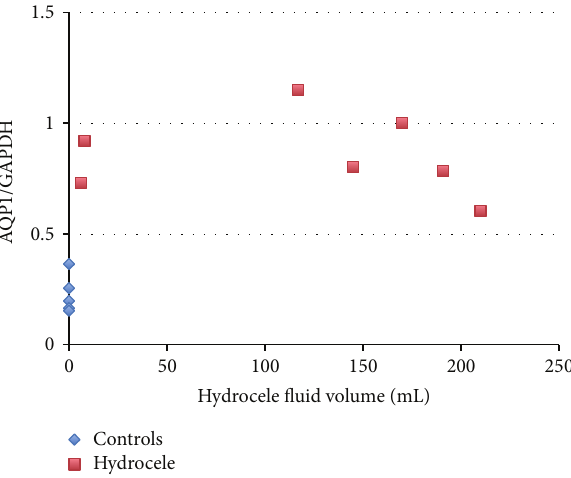
Figure 2: Scatter diagram of the ratio of the AQP1 signal to GAPDH and volume of hydrocele fluid. Controls were plotted with a fluid volume of